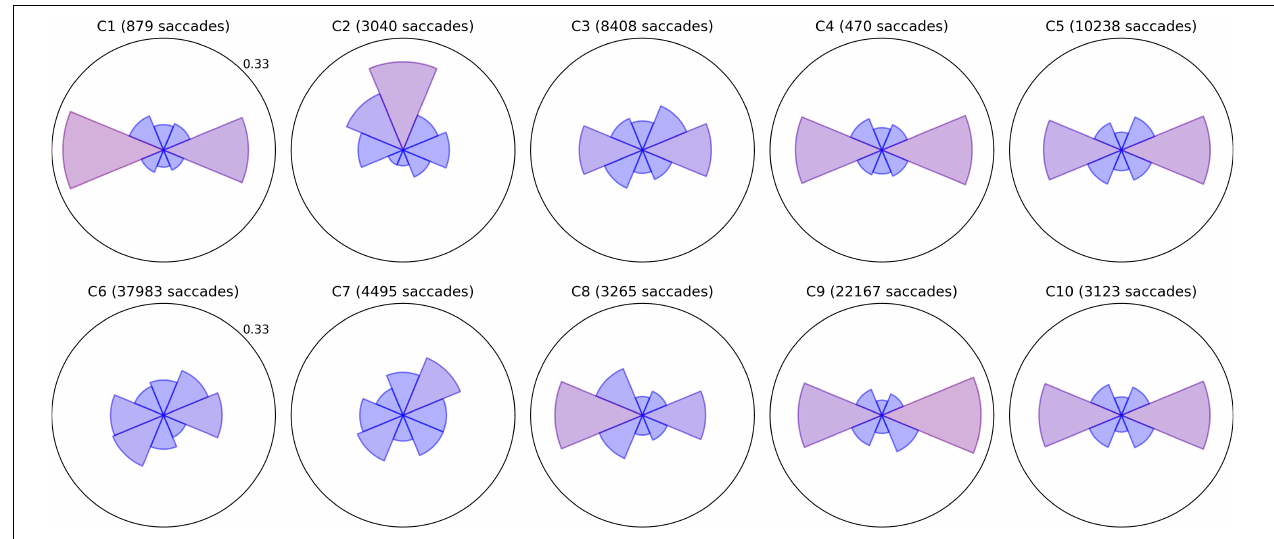
FIGURE 2 | Radial histograms of saccade frequency. Saccades in the Bubble Burst task were binned into eight directions. The upper radial axis limit of each plot is a proportional score of 0.33. The sector bins gradually change in color from blue to red as the proportion for that bin exceeds the mean of 0.125, which allows the more biased directions to be identified at a glance. The participant number and total saccade count are given above each plot.